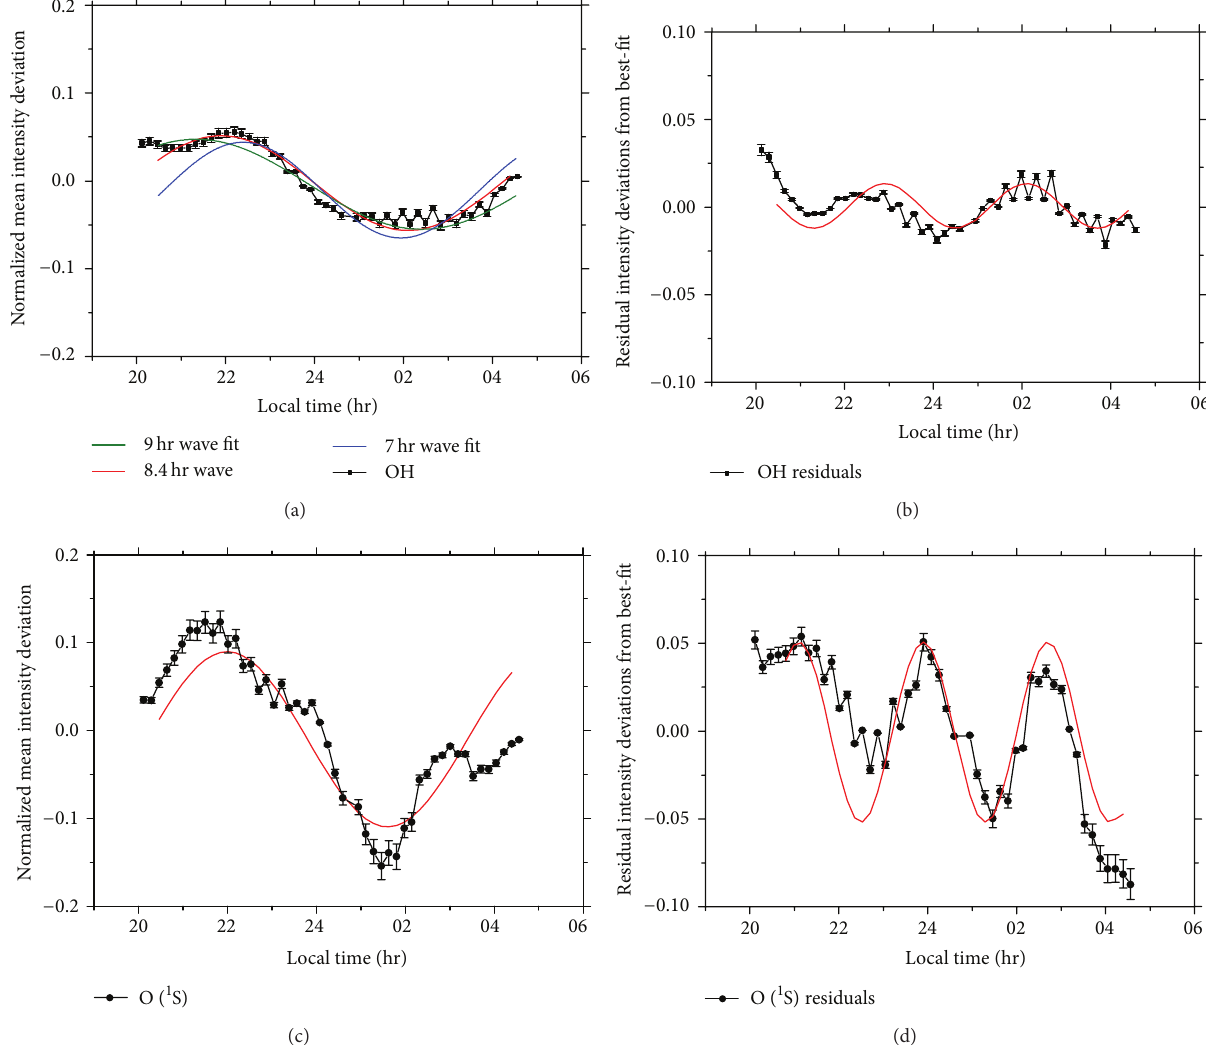
Figure 1: The observed nocturnal variability noted on February 9-10, 2010 in OH (a, b) and O ( 1 S) emission (c, d) intensities. The solid lines in each plot exhibit the best-fit model results. (a, c) show the intensity deviations from the nightly average, normalized to their nightly averages. (a) shows the sample wave-fit results for two other wave modes together with the selected 8.4 hr wave. One may note the presence of principal nocturnal wave (a, c) and residual wave (b, d) in the